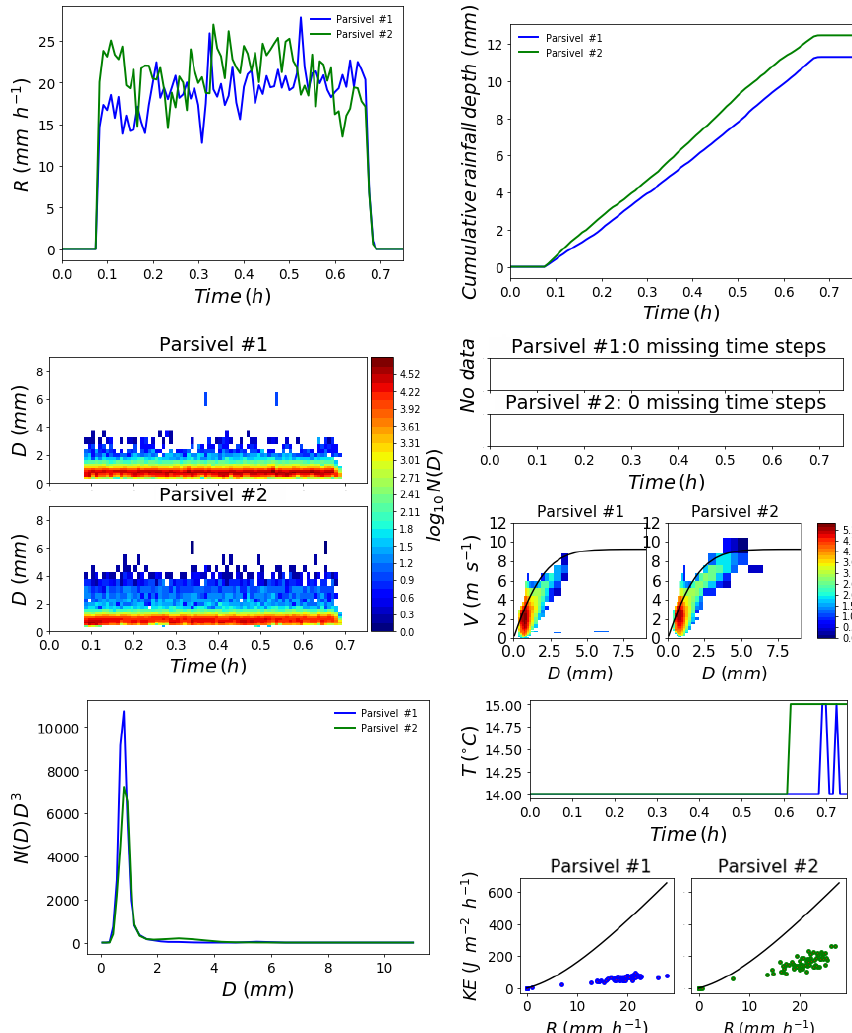
Figure 4. Quicklook of the measurements at location no. 1 with light